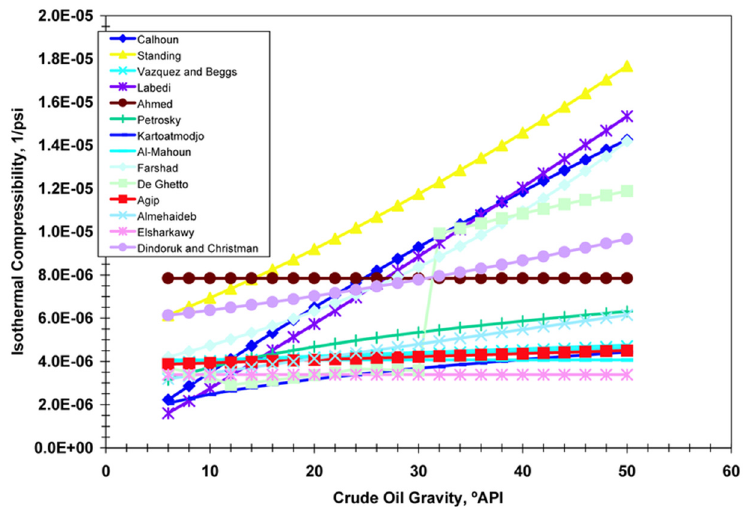
Figure 6. Isothermal compressibility vs. crude oil gravity (https: // petrowiki.org / File:Vol1_Page_284_